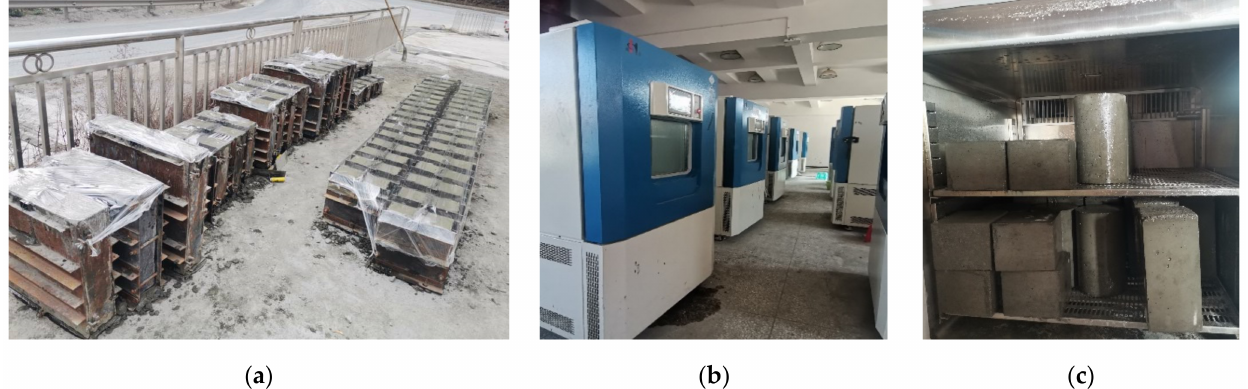
Figure 4. Curing of concrete specimens: ( a ) the surface of the specimen was covered with plastic wrap to prevent the loss of concrete moisture; ( b ) large temperature and humidity environmental chamber; ( c ) an example of three different types of specimens cured in the environmental chamber.